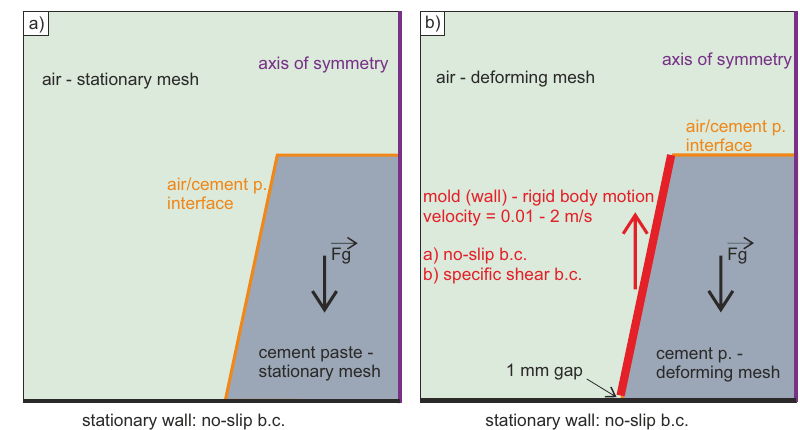
Figure 1. Schematic set up of mini-slump (symmetric part of the cone is shown) test with shown boundary conditions a) without mold b) with